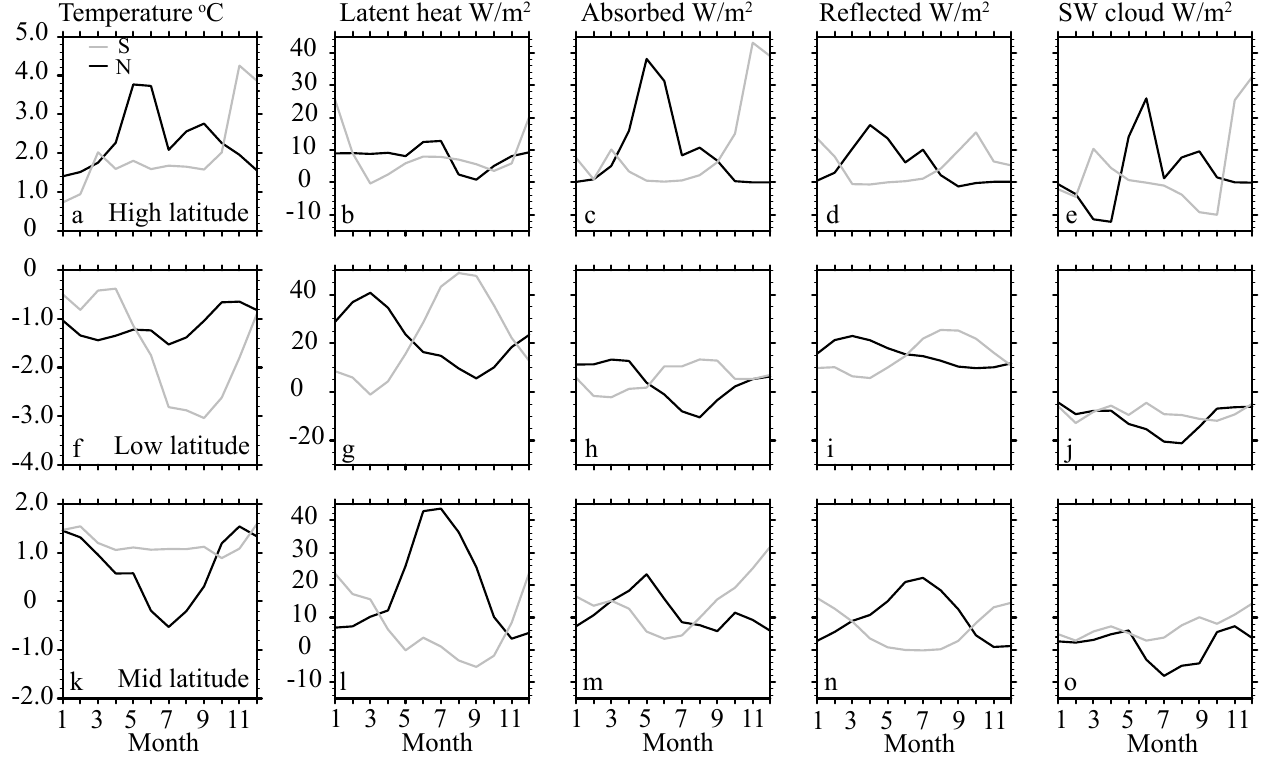
Fig. 5. Annual cycles of surface temperature ( ◦ C), latent heat fluxes (Wm − 2 ) , surface absorbed solar radiation (Wm − 2 ) , surface reflected solar radiation (W m − 2 ) , surface shortwave cloud forcing (Wm − 2 ) over the high-latitude forests (a–e) , low-latitude forests (f–j) and mid- latitude forests (k–o) for 10xDGVM–10xBG experiments. Solid black lines denote changes in the Northern Hemisphere and grey lines denote changes in the Southern Hemisphere. Low, mid and high latitudes are defined as 30 ◦ S–30 ◦ N, 30–50 ◦ S/ ◦ N and 60–90 ◦ S/ ◦ N,